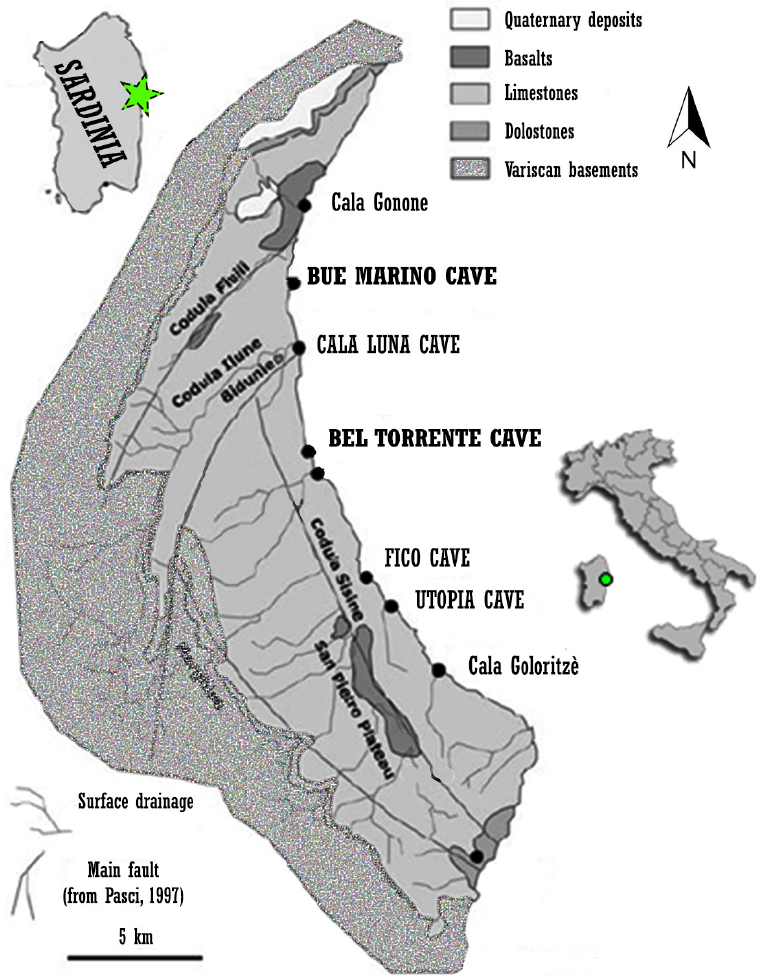
Figure 2. Geological scheme of the Gulf of Orosei with the location of the marine caves [modified from [103]].